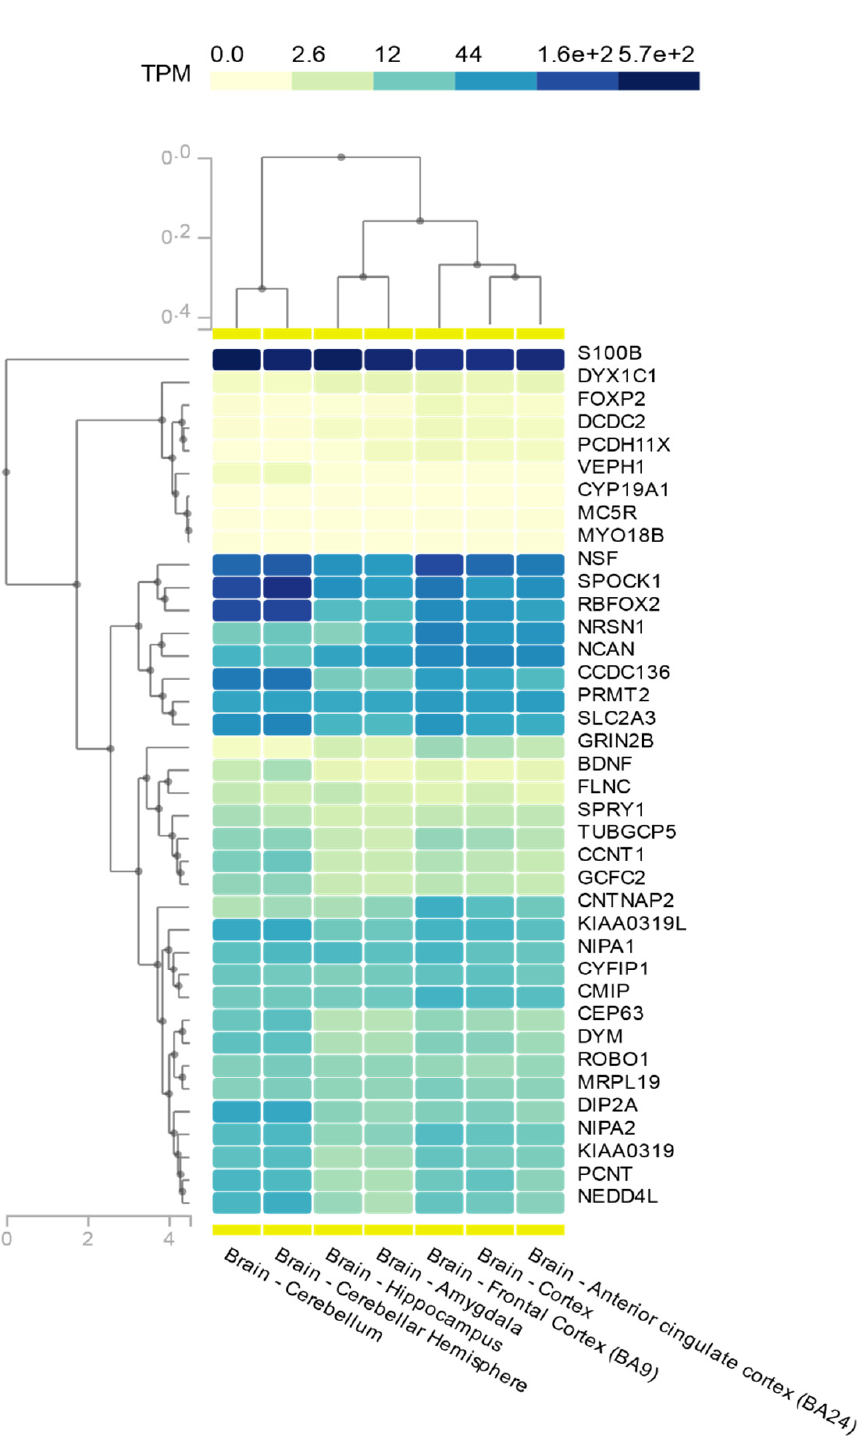
Figure 1. Heatmap of RNA-sequencing-based gene expression from the SLD-associated (protein- coding) genes presented in Table 5, generated in GTEx portal for a multi-gene query in seven brain areas (basal ganglia and hypothalamus are excluded) [204]. SLC2A3 on chromosome 12 was included as an indirectly associated gene (potentially being trans -regulated by a directly associated variant on chromosome 4) (see text in Section 3). PCDHG represents a whole gene cluster, thus excluded from the query. TPM: Transcripts per kilobase million (expresses RNA-sequencing reads normalized for gene length and sequencing depth).